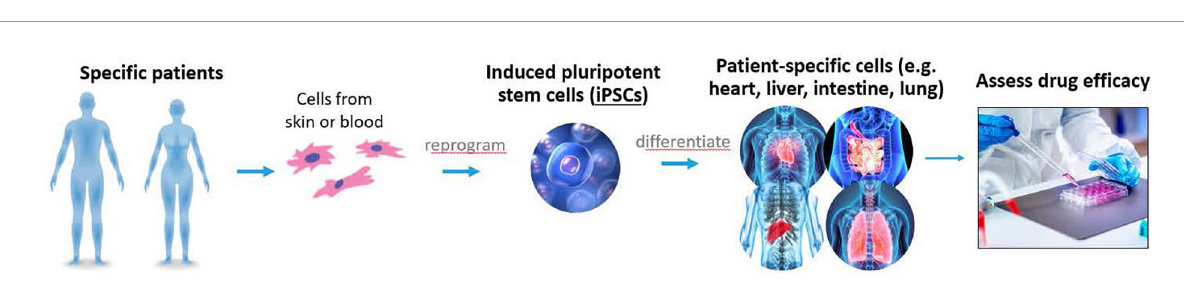
FIGURE9 Complex in vitro models, induced pluripotent stem cells (iPSCs), and other non-clinical methods are some of the tools being evaluated by division of applied regulatory science (DARS) to help advance therapies for rare